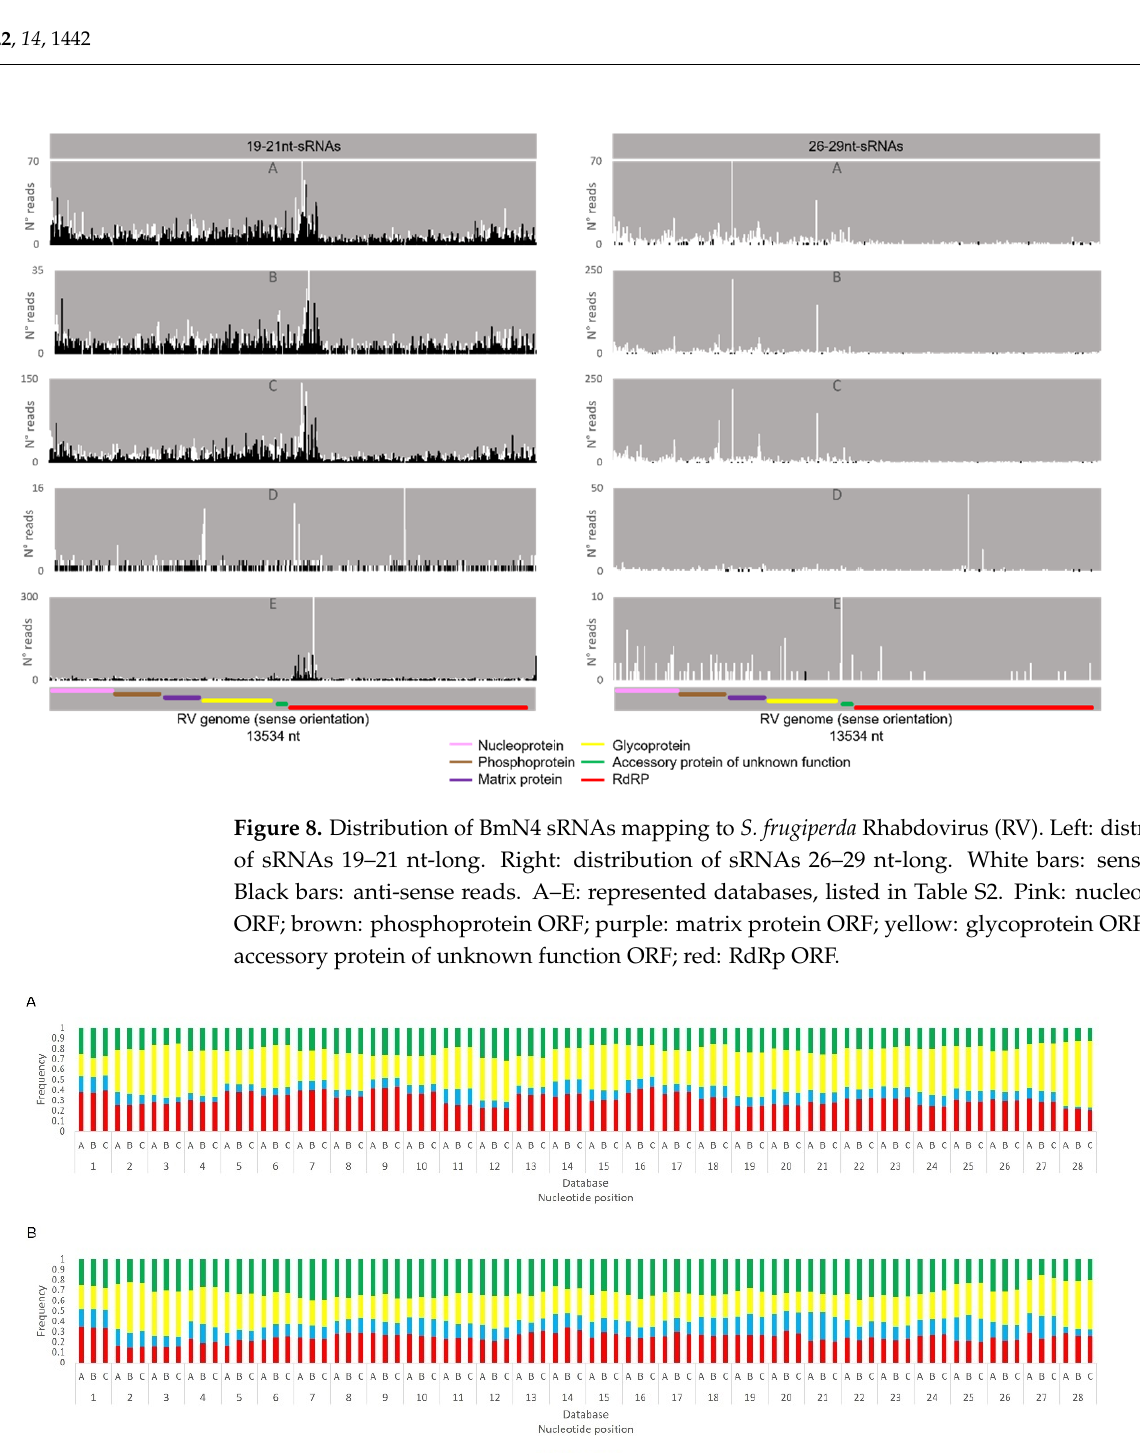
Figure 9. Relative nucleotide frequency of BmN4 28 nt-long sRNAs, mapped to the genome of B. mori Macula-like Latent Virus (MLV) ( A ) and S. frugiperda Rhabdovirus (RV) ( B ), databases A–C (Table S2). The Y -axis represents the relative nucleotide frequency. The X -axis represents the position in the read. T: thymine; G: guanine; C: cytosine; A: adenine. Since the sequenced reads correspond to cDNA, thymine corresponds to uracil in the original RNA molecule.